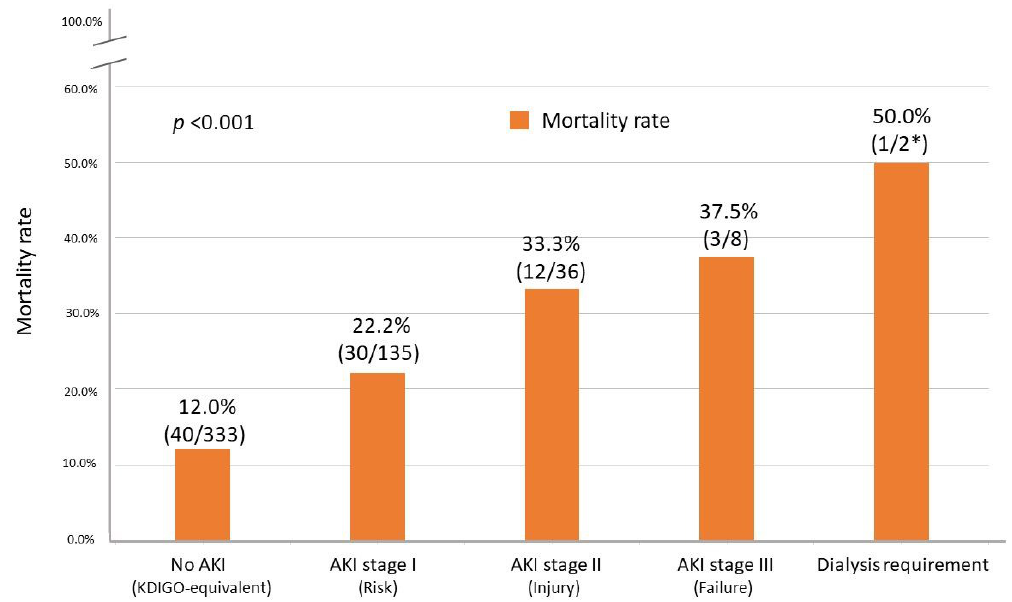
Figure 3. All-cause mortality rate after living donor liver transplantation with increasing stages of postoperative acute kidney injury. KDIGO—Kidney Disease Improving Global Outcome. * These post-LT AKI patients needing dialysis therapy were also included in the group of AKI stage III.